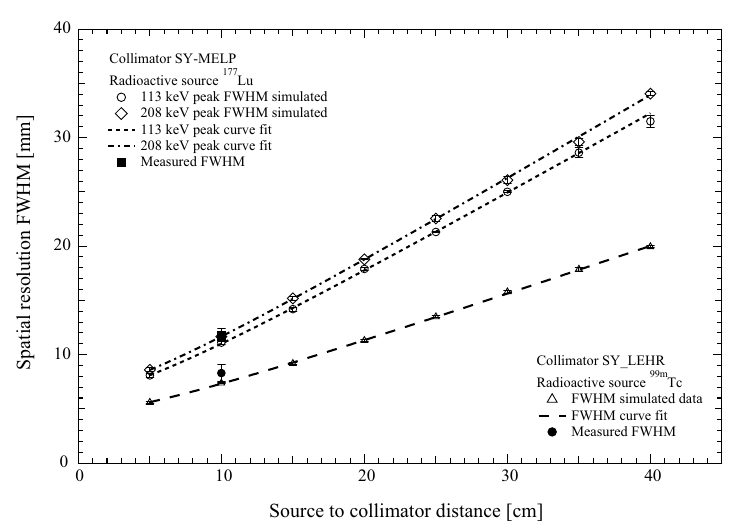
Fig. 2 Simulated Spatial resolution for 99 m Tc and 177 Lu. Plot of spatial resolution as function of distance between source and detector for 99 m Tc and 177 Lu